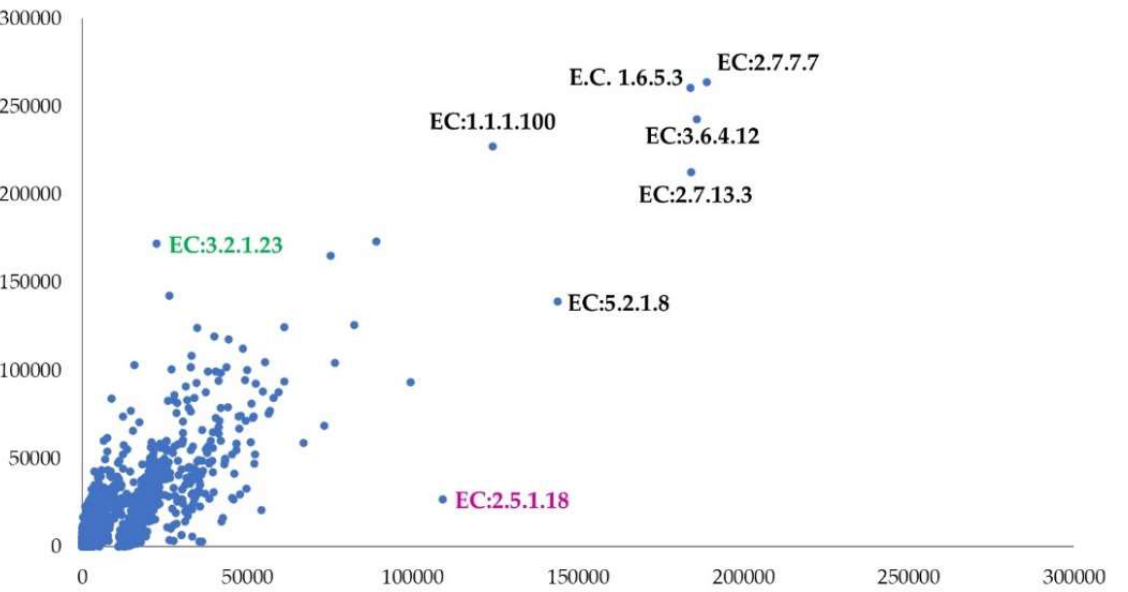
Figure 4. Correlation plot on enzymes predicted by PICRUSt 2 software [37] (nodule y axis and rhizosphere x axis). In Figure 4, the EC codes refer to the enzyme commission numbers of the KEGG database. Only ECs with relative counts higher than 100,000 were labeled in black. The green label highlights the EC with higher counts in nodule sample while the magenta one shows the EC with higher counts in the rhizosphere. Correlation coefficient: 0.84.